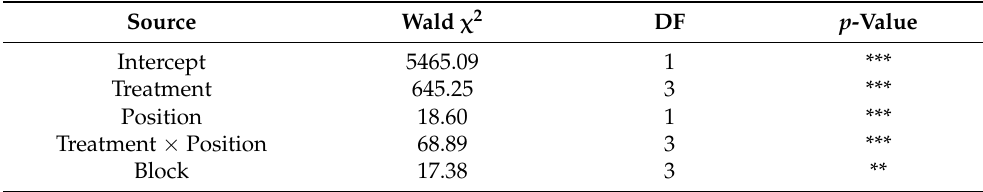
Table A2. Results of repeated-measures analysis with generalized linear model testing the effects of the independent variables block, treatments, positions, and their interaction on weed cover